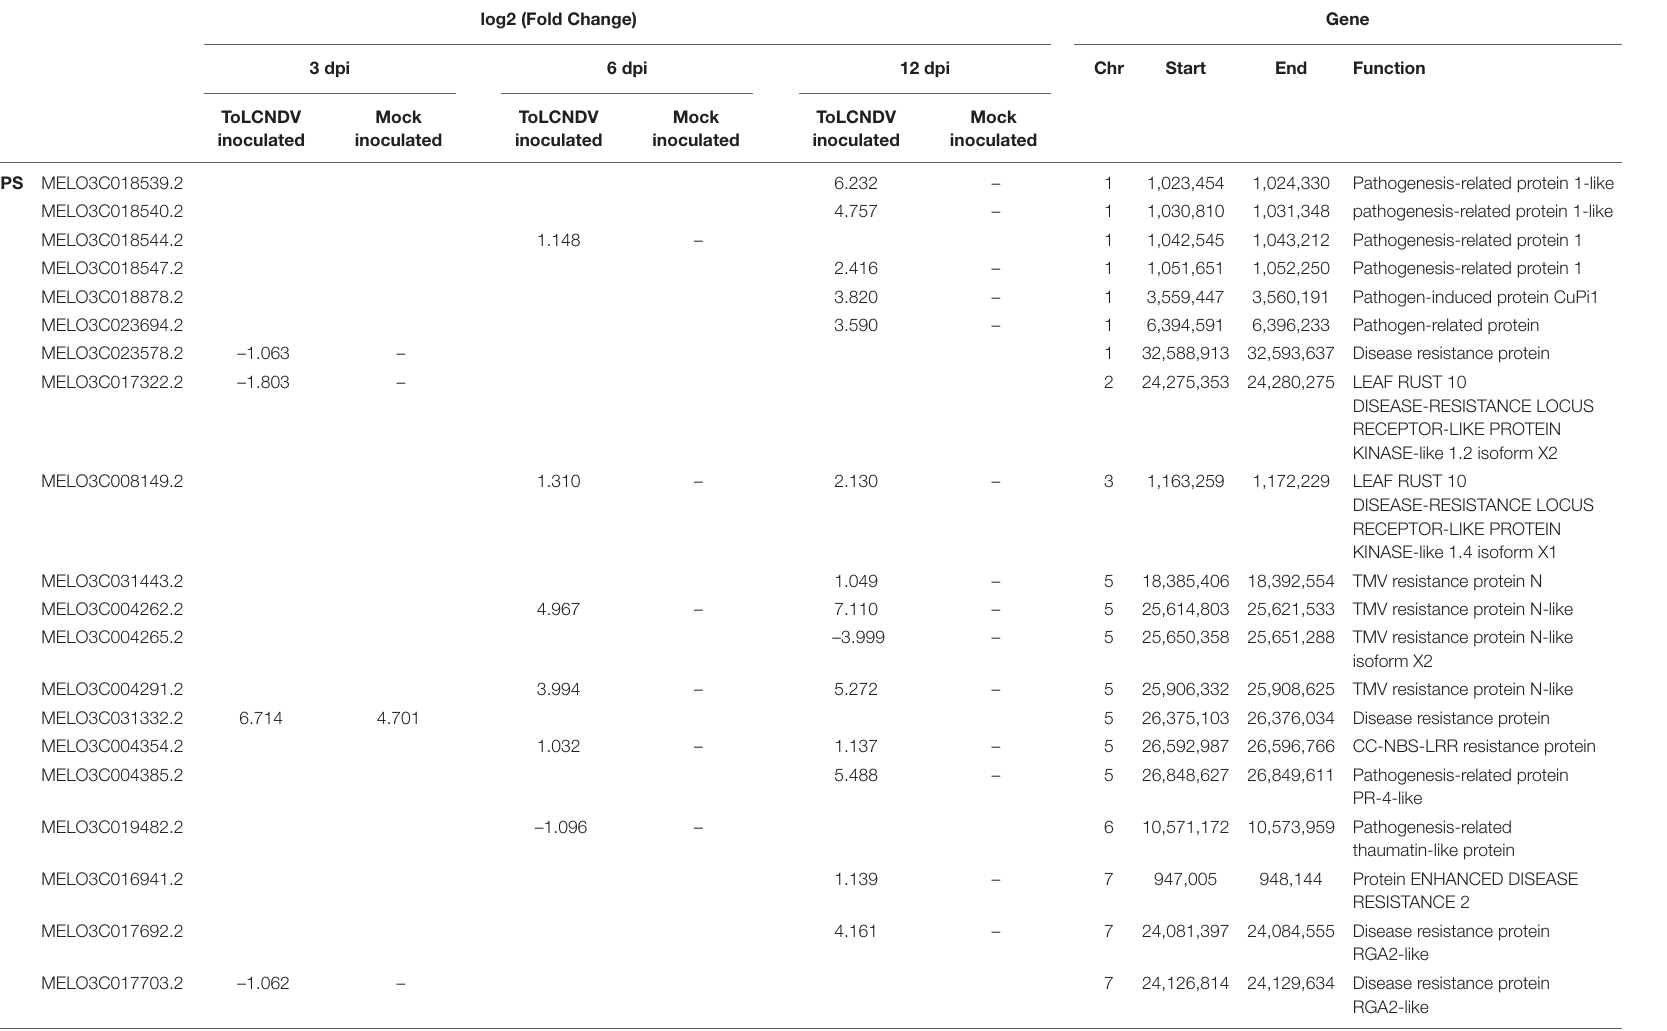
TABLE 4 | Expression pattern of additional selected genes conferring resistance to pathogens. log2 (Fold Change)